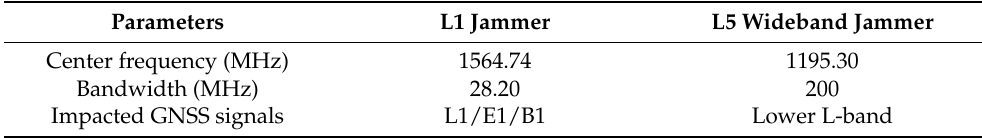
Figure 4. Frequency spectrum of the L1 jammer ( left ) and the L5 wideband jammer ( right ). Table 3. Jamming signal parameters.